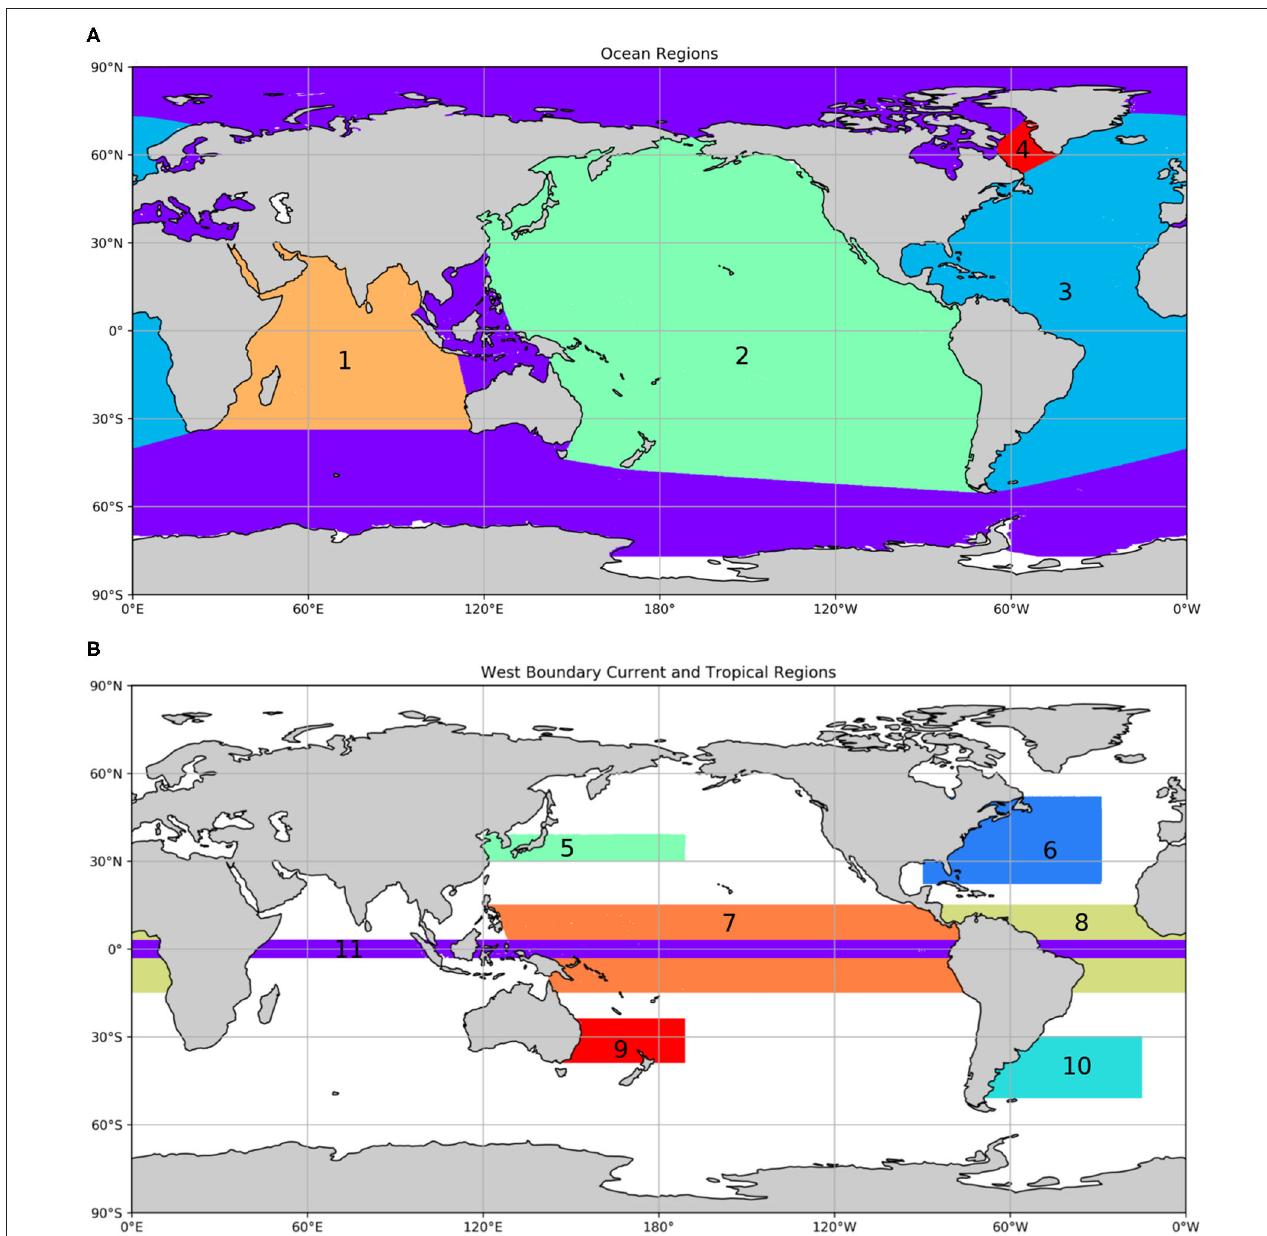
FIGURE 6 | The regions used to assess the impacts of additional or removal of observations: (A) ocean basin wide regions and (B) western boundary current regions included in the paper: 1. Indian Ocean, 2. Pacific Ocean, 3. Atlantic Ocean, 4. Labrador Sea, 5. Kuroshio Current, 6. Gulf Stream and extension, 7. Tropical Pacific, 8. Tropical Atlantic, 9. East Australian Current, 10. Brazil Current, and 11.